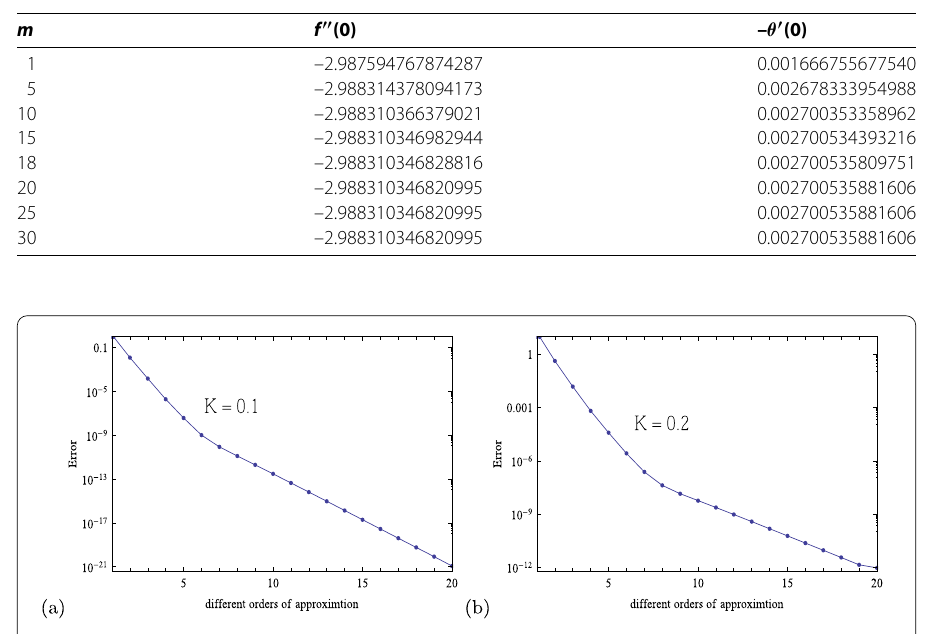
Table 3 Convergence of HAM on the basis of skin friction f (cid:2)(cid:2) (0) and heat flux – θ (cid:2) (0) for selected values of Ma = 1, M = 1, ϒ = 0.127013, Pr = 0.2, Gr = 5, S = 0.2 and K = 0.1